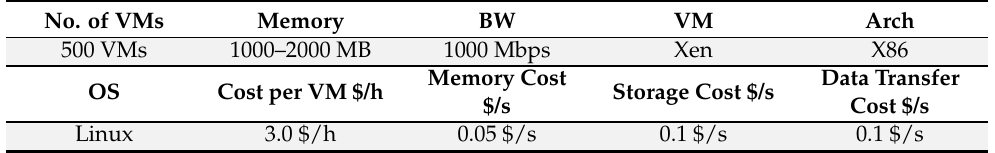
Table 2. The resource experimental